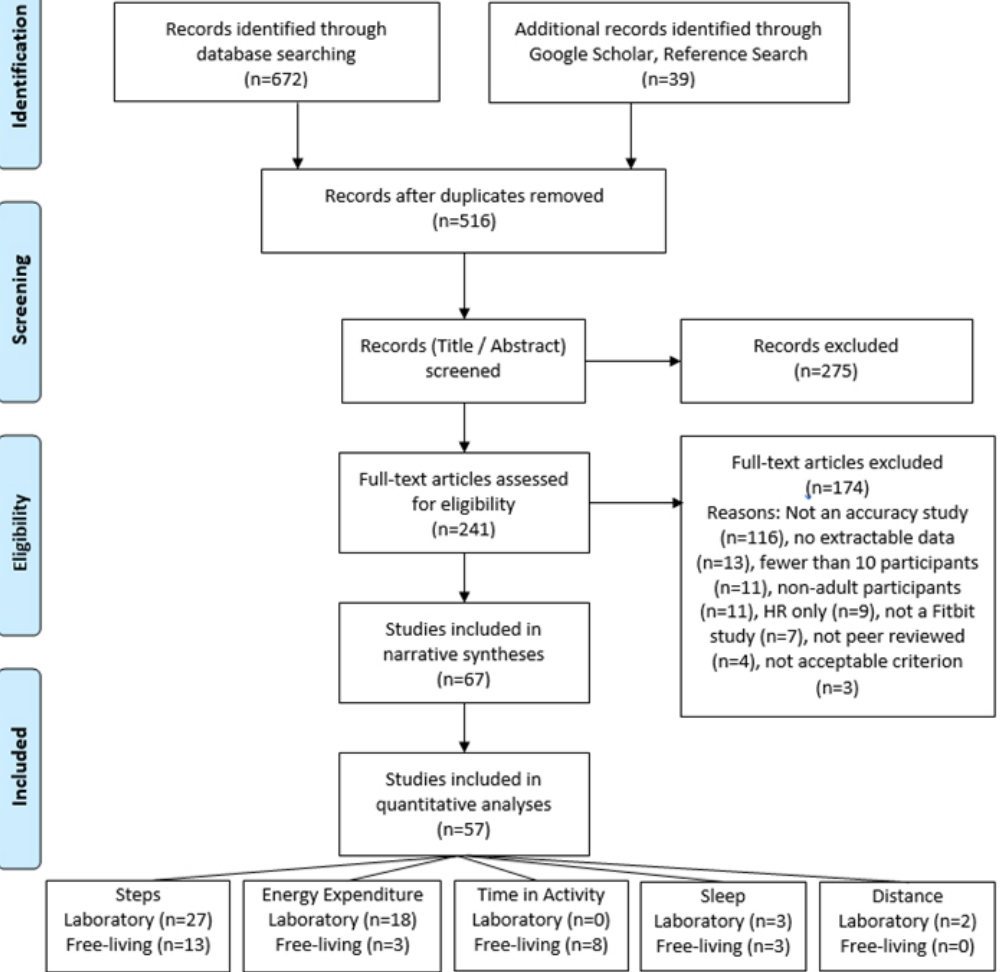
Figure 1. Preferred Reporting Items for Systematic Reviews and Meta-Analyses (PRISMA) flow